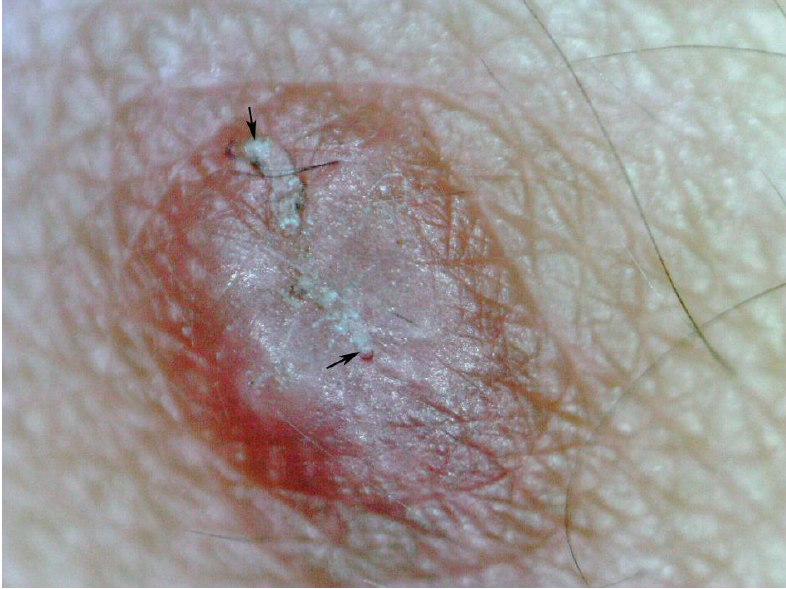
Figure 11. Nodule containing two mites (arrows); magnification 25-fold.